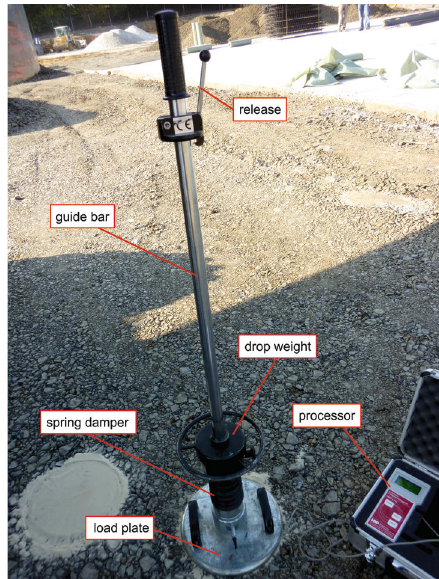
Figure 4. Experimental setup for a dynamic plate load